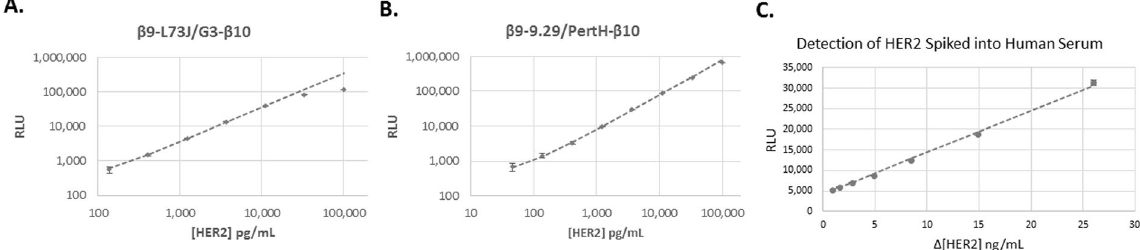
Figure 6. The linear range and limit of detection for homogeneous HER2 TEC assays. For these assays, a complete detection solution was used consisting of the β 9- and β 10-fused binders, Δ 11S lysate diluted 1:20, and 10 μ M Nano-Glo substrate. ( A ) For β 9-L73J (12.5 nM)/G3- β 10 (2.5 nM), the limit of detection was determined to be 137 pg/mL, and the signal was linear up to 11 ng/mL. ( B ) For β 9-9.29 (2 nM)/PertH- β 10 (20 nM), the limit of detection was determined to be 45 pg/mL, and the signal was linear up to approximately 100 ng/mL. ( C ) Demonstration that TEC can be used to detect HER2 in 100% human serum. The TEC signal was linear down to a change of sub-ng/mL concentrations ( Δ = 900 pg/mL), p < 0.001 between response for 9.8, 10.7, 11.4, and 12.5 ng/mL HER2. In general, human serum contains a normal HER2 level of ~9.8 ng/mL, preventing the analysis of a “blank” sample. 15 ng/mL is the established threshold separating normal for elevated HER2